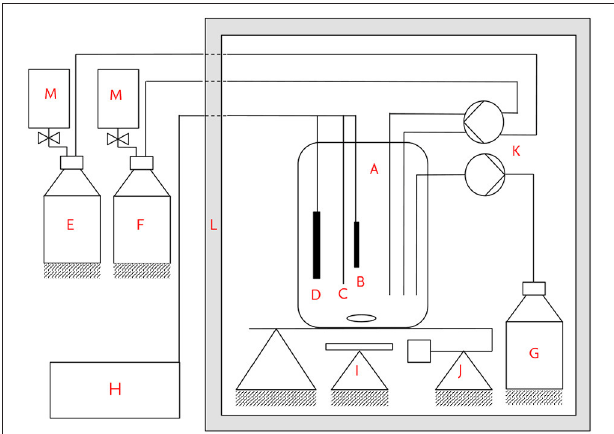
FIGURE 1 | Experimental set up. (A) Reaction vessel, (B) working electrode, (C) reference electrode, (D) counter electrode, (E) glycerol solution bottle, (F) vitamin and trace element solution bottle, (G) effluent bottle, (H) potentiostat, (I) magnetic stirrer, (J) balance, (K) three-channel peristaltic pump, (L) heating cabinet, (M) nitrogen gas